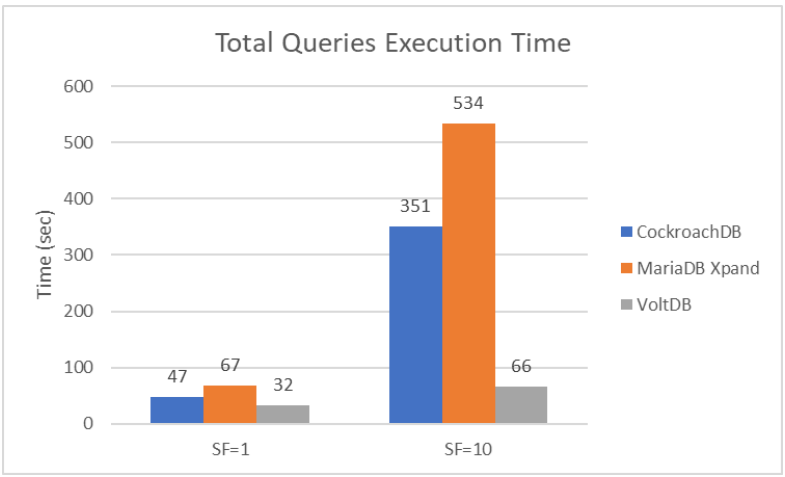
Figure 14. Sum of queries between SF = 1 and SF = 10.